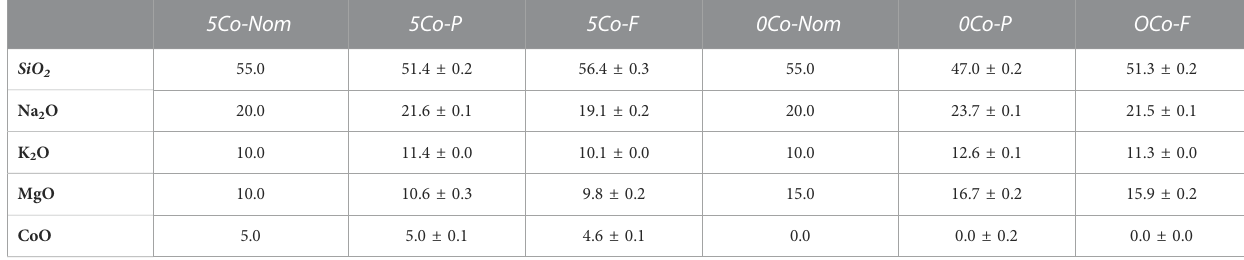
TABLE 1 Nominal glass compositions (5Co-Nom and 0Co-Nom) used in this study, and the measured compositions of the glass fi bres (5Co-F and 0Co-F) and particles(5Co-Pand0Co-P)inmol%(ICP),showing similar valuesforthe measuredandtheoretical values.Data areshownasthe composition ±maximumerrorin the ICP-OES